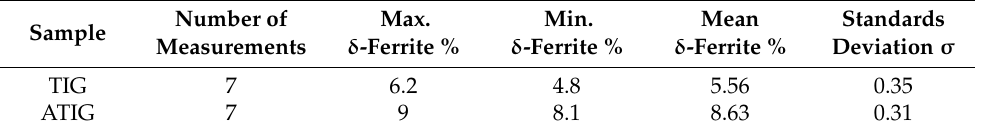
Table 11. Ferrite volume fraction